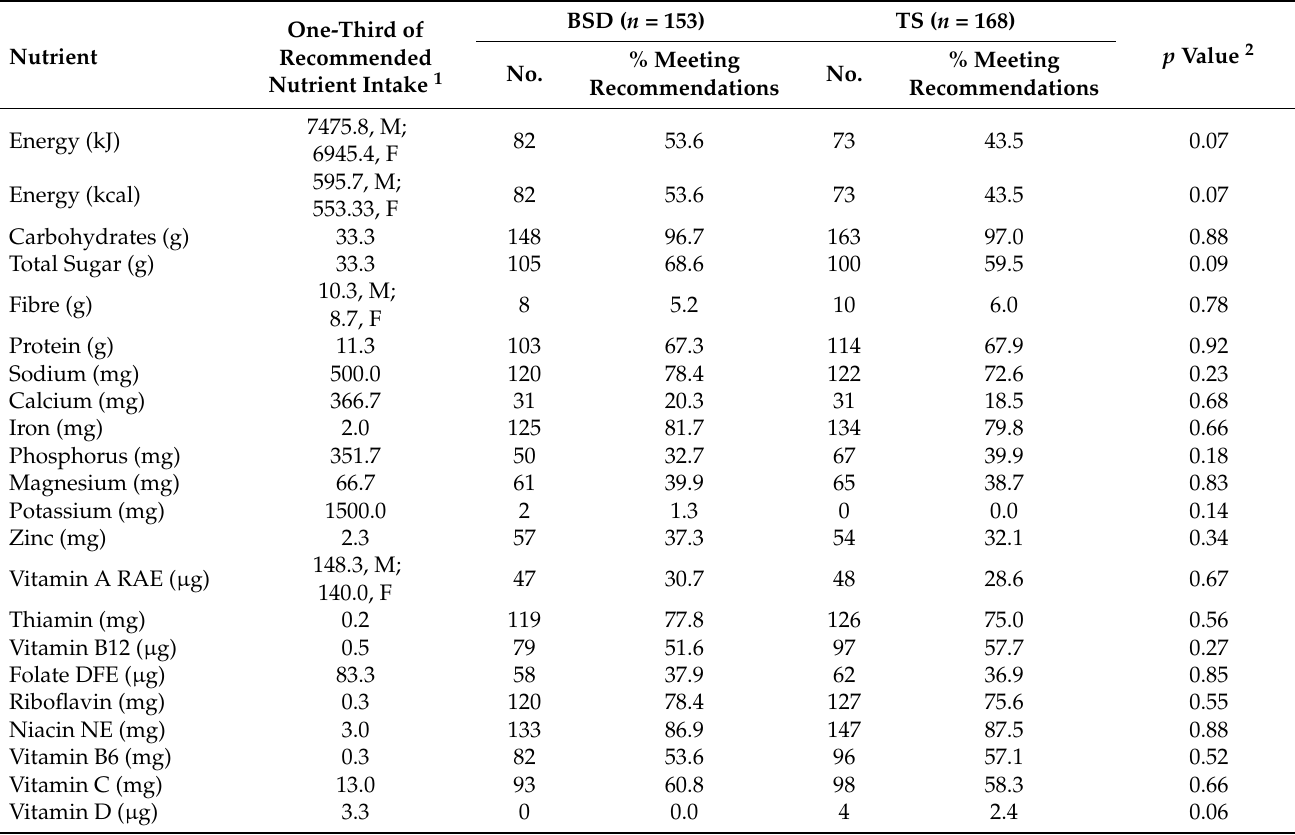
Table 4. Proportion of children consuming one-third of recommendations, by school schedule.